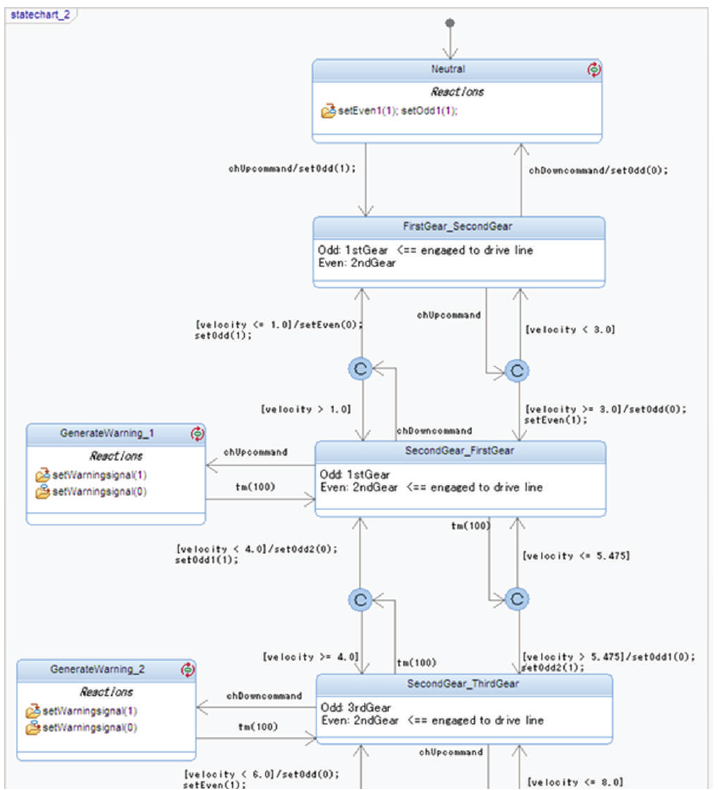
Figure 15: Part of Controller software